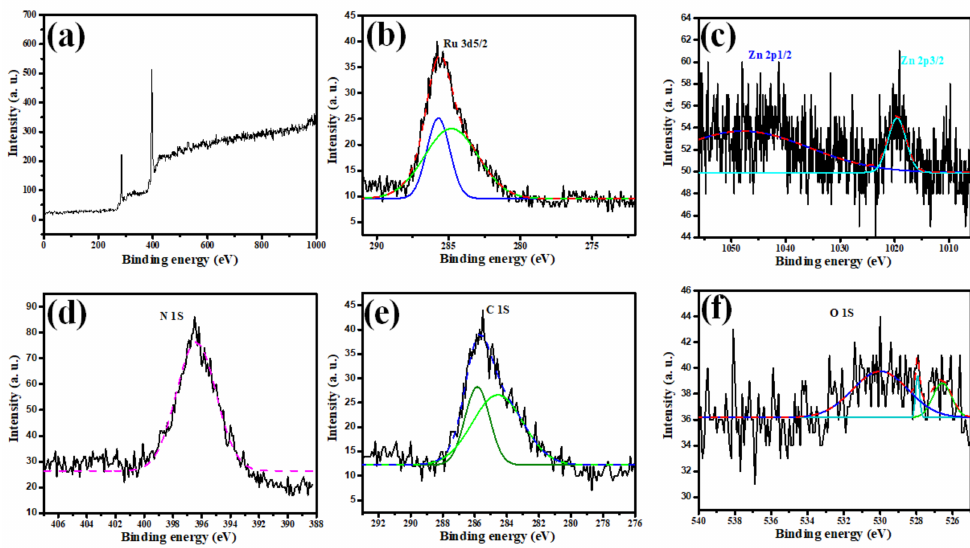
Figure 6. XPS analysis of Ru-ZnO@g-C 3 N 4 photocomposite ( a ) full survey and individual spectra of ( b ) Ru 3d, (c ) Zn 2p, ( d ) N1s, ( e ) C1s, and ( f )